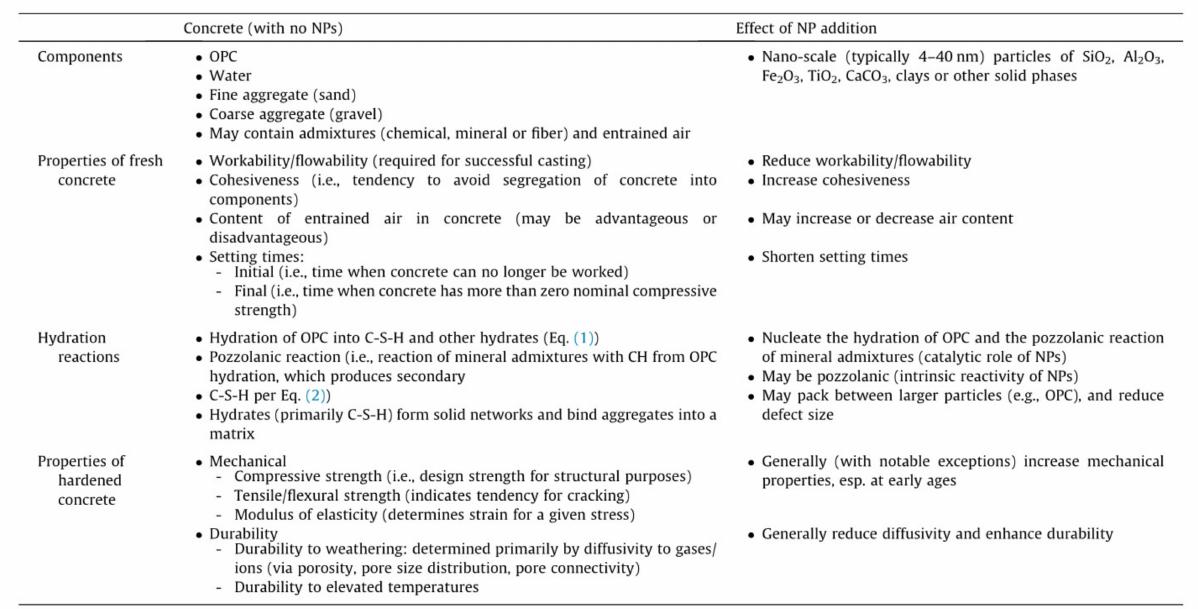
Figure 7. Difference between a GBS and a floating structure (Marinero 2018) [29].